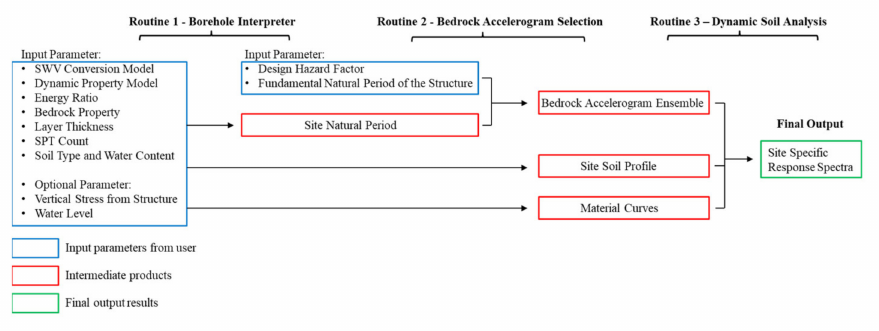
Figure 1. Procedures for generating a site-specific response